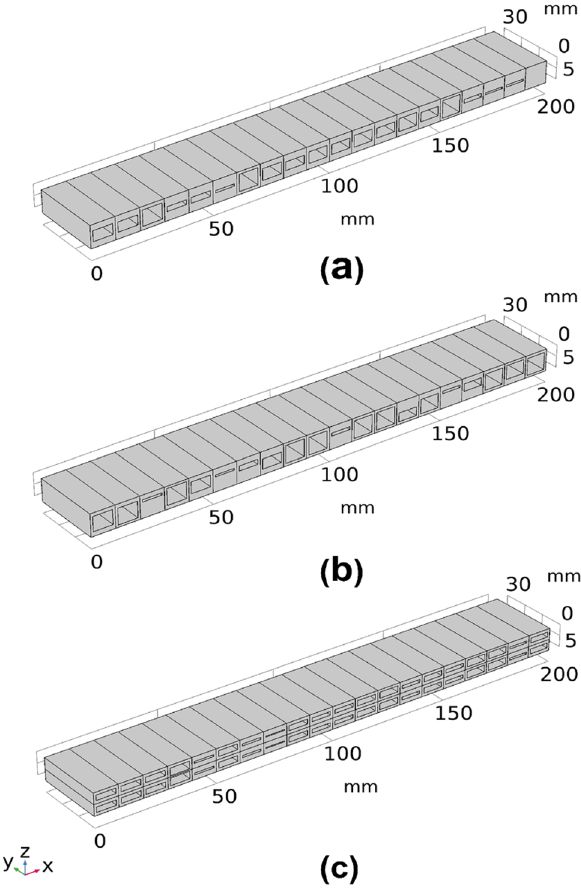
Figure 3. CAD models of the 20 voxel structures with the three different voxel cellular geometry settings; ( a ) single symmetric void, ( b ) single asymmetric void and ( c ) double void settings. (Images are created by the authors using Solidworks Educational Version 30.3.1.2